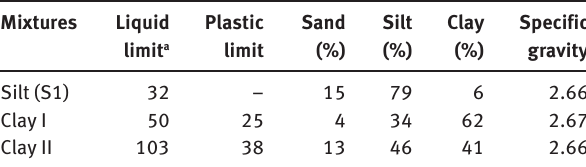
Table 1 Geotechnical index properties of silt and